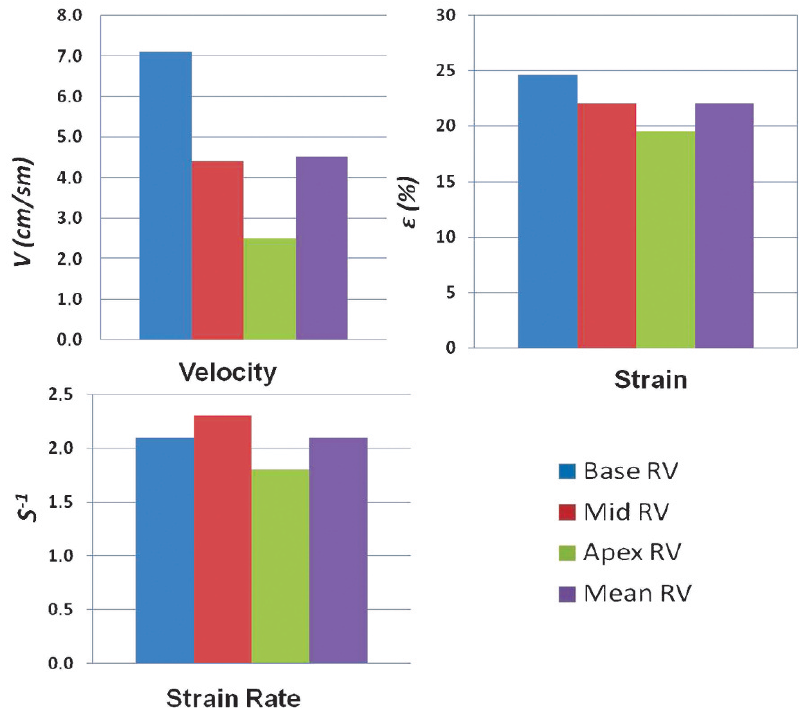
Figure 3 - Myocardial velocity, strain, and strain rate values of the basal, mid, and apical segments of the right ventricle in the control